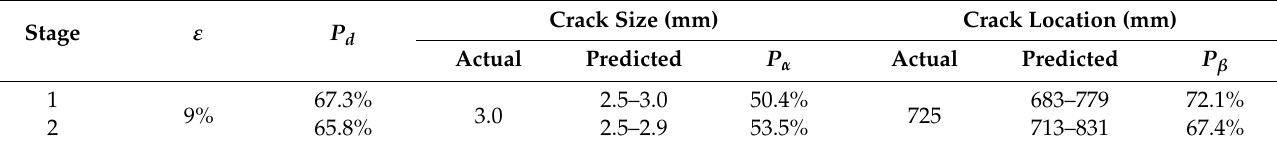
Table 4. Results summary for Case